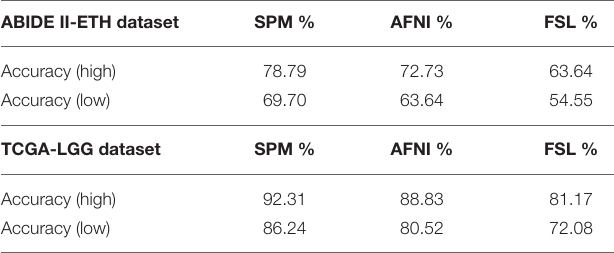
TABLE 5 | Prediction results on two